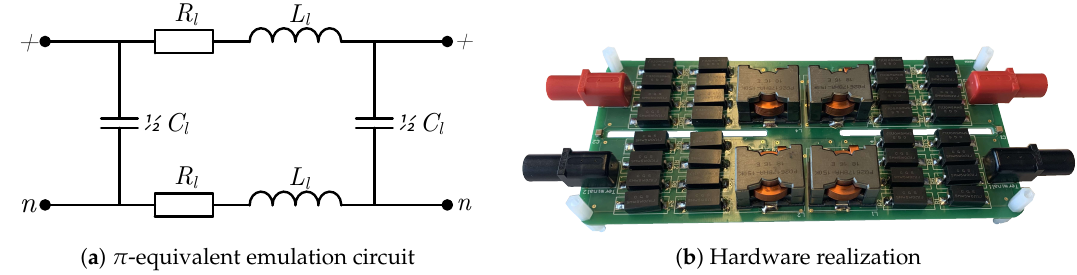
Figure 5. Lumped element emulation circuit that is used to emulate a 100 m distribution